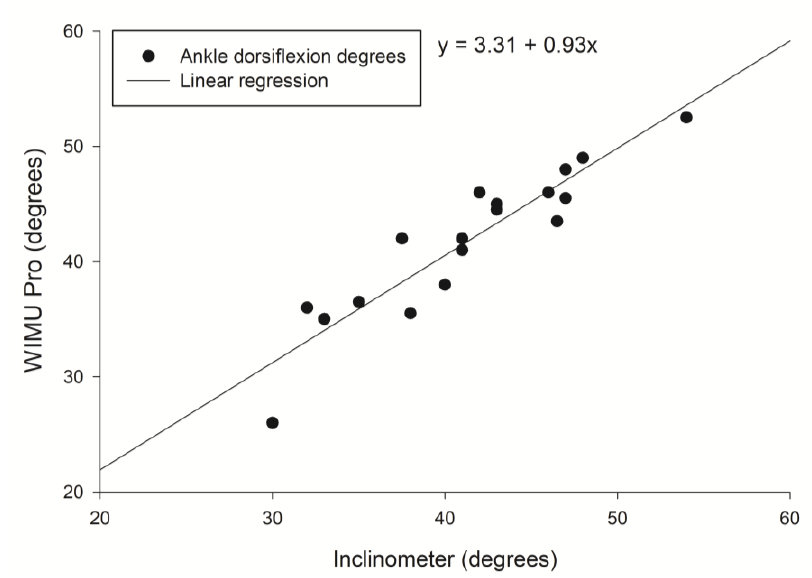
Figure 3. Correlation between left ankle dorsiflexion (degrees) measured by the inclinometer and WIMU Pro.